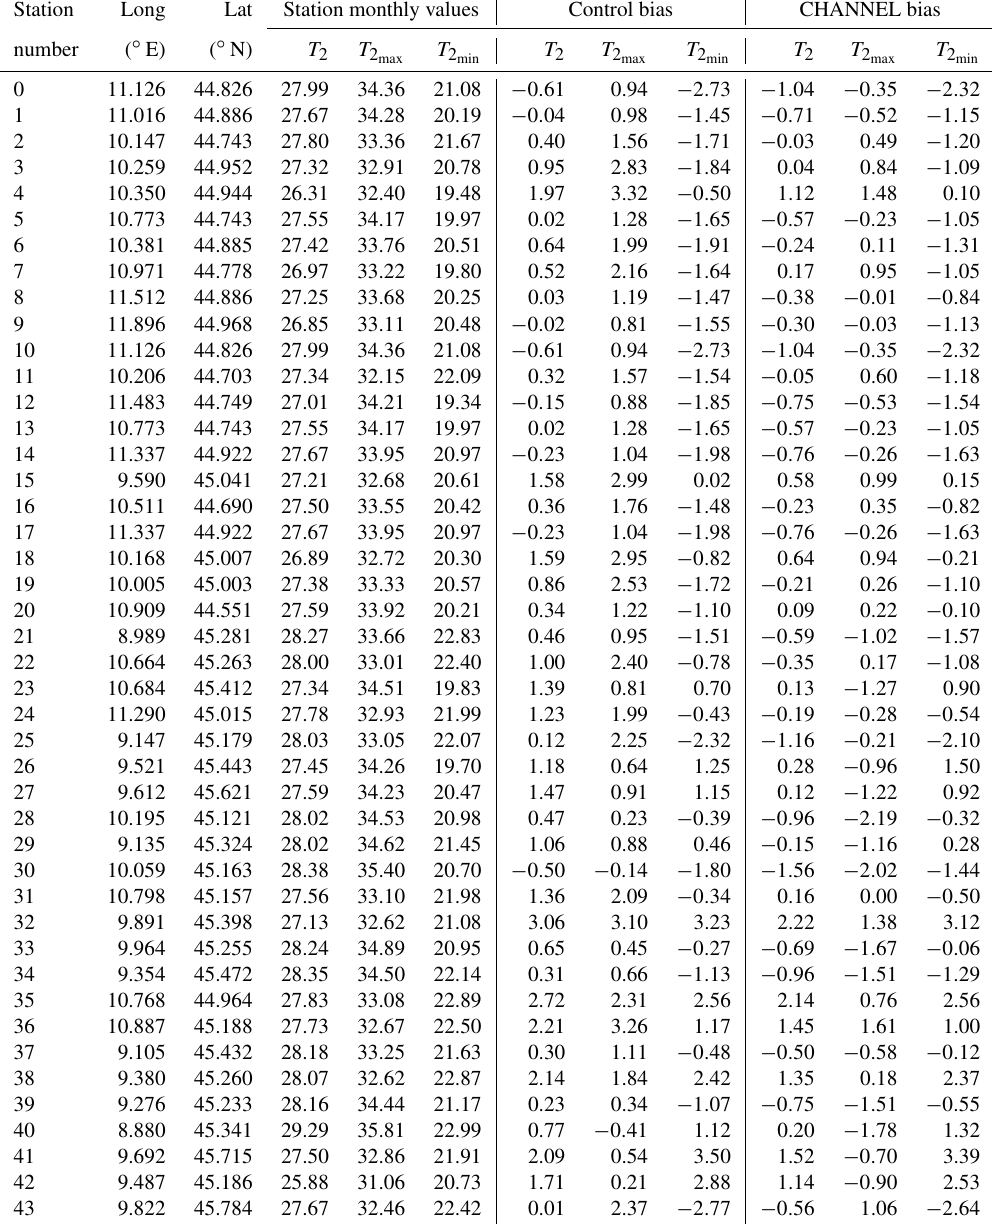
Table A1. Monthly averaged mean, maximum, and minimum values obtained for each station in Figs. 5–7.